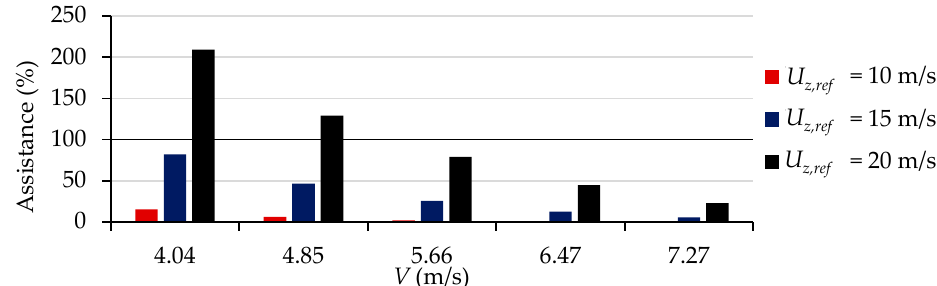
Figure 15. The maximum kite thrust achieved for different wind and ship speeds and a kite area of 320 m 2 as a percentage of the total ship resistance at the corresponding ship speed.